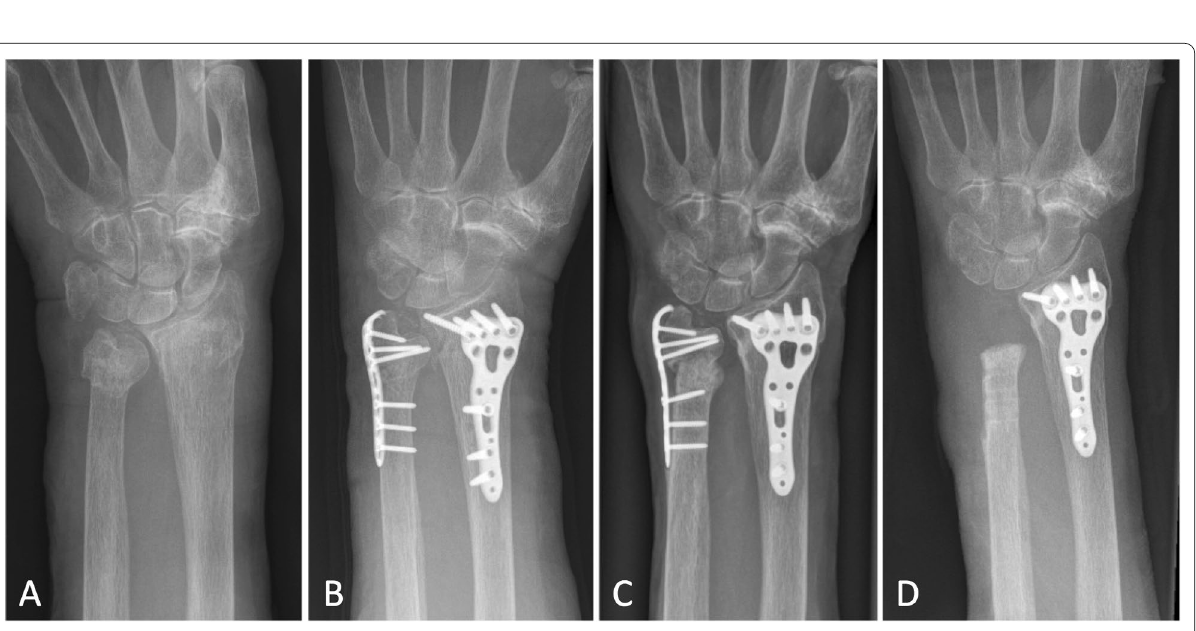
Fig. 2 Nonunion after ulna plate osteosynthesis in an old patient. A Preoperative radiograph of a 93‑year‑old female presenting a Biyani type IV left distal ulna fracture combined with a type C distal radius fracture. B Immediate postoperative radiograph showing left wrist osteosynthesis with ulna hook plate and radius volar plate. C One‑year postoperative radiograph showing ulna and radius fracture nonunion. D Radiograph after ulna head resection (Darrach) due to ulna